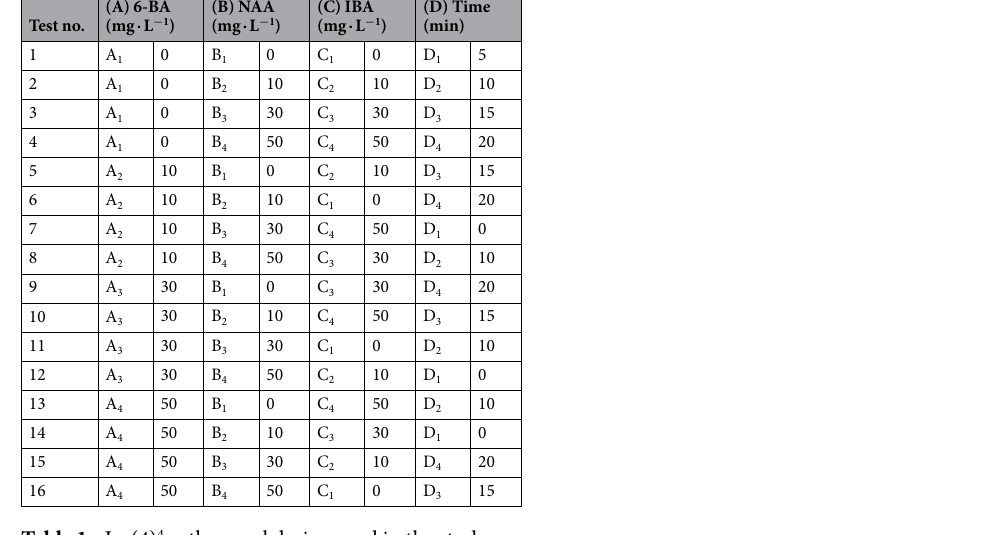
Table 1. L 16 (4) 4 orthogonal design used in the